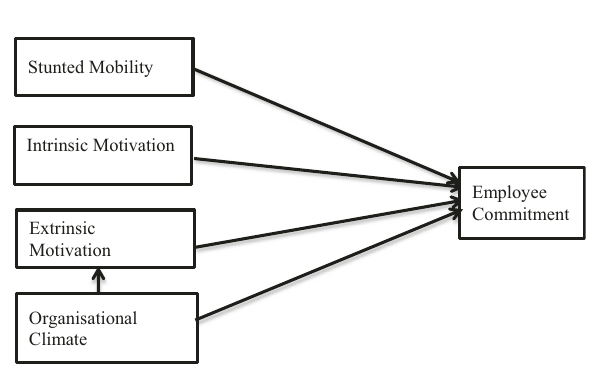
Fig. 3 Proposed model of determinants of employee commitment. Source: Author ’ s proposed model of the study